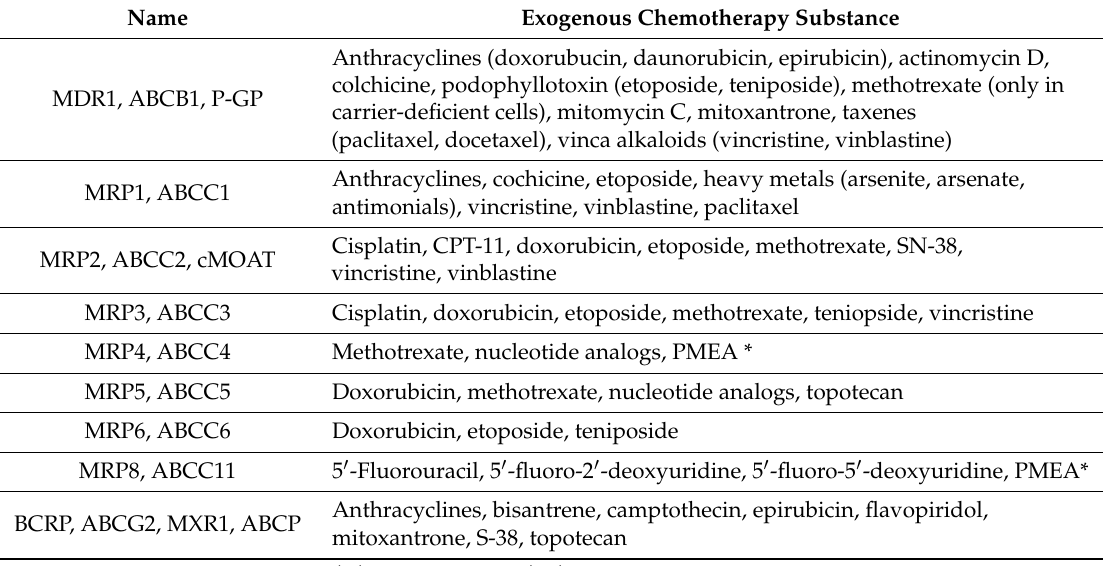
Table 1. Chemotherapy substrates for ATP-binding cassette (ABC) transporters (adapted from